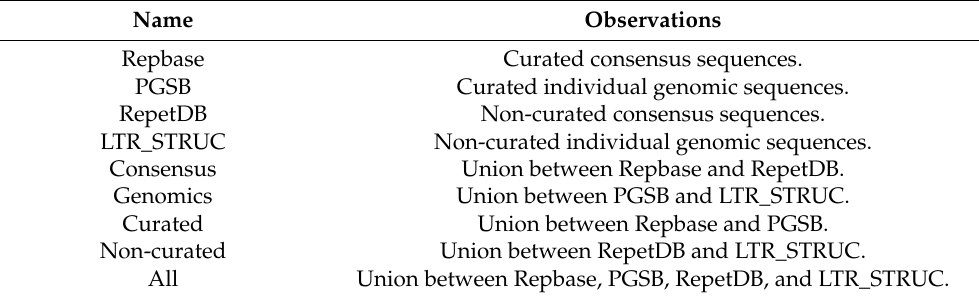
Table 1. Datasets used in the statistical analysis of machine learning (ML)